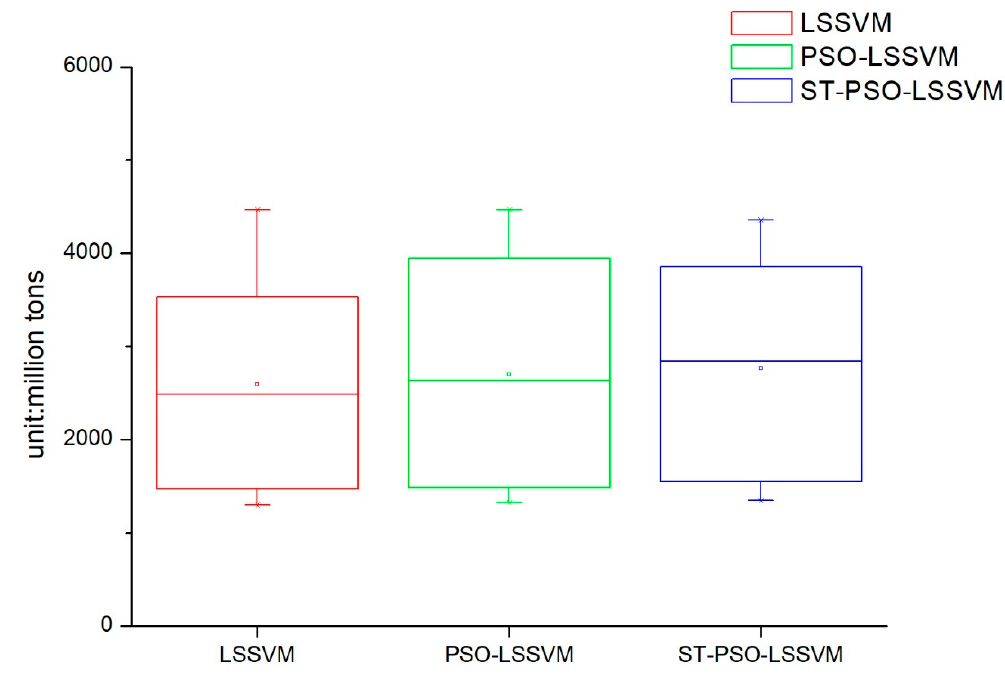
Figure 6. Boxplots of the three forecasting models’ results.